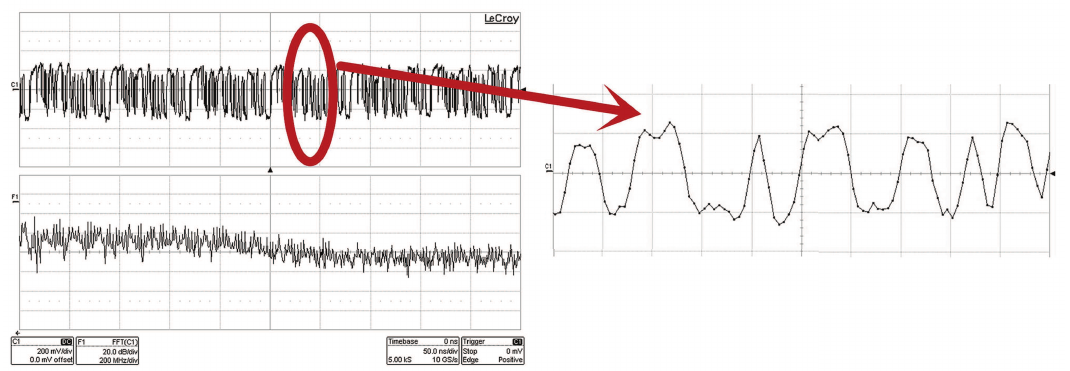
Figure 14. Time and frequency domain of periodic